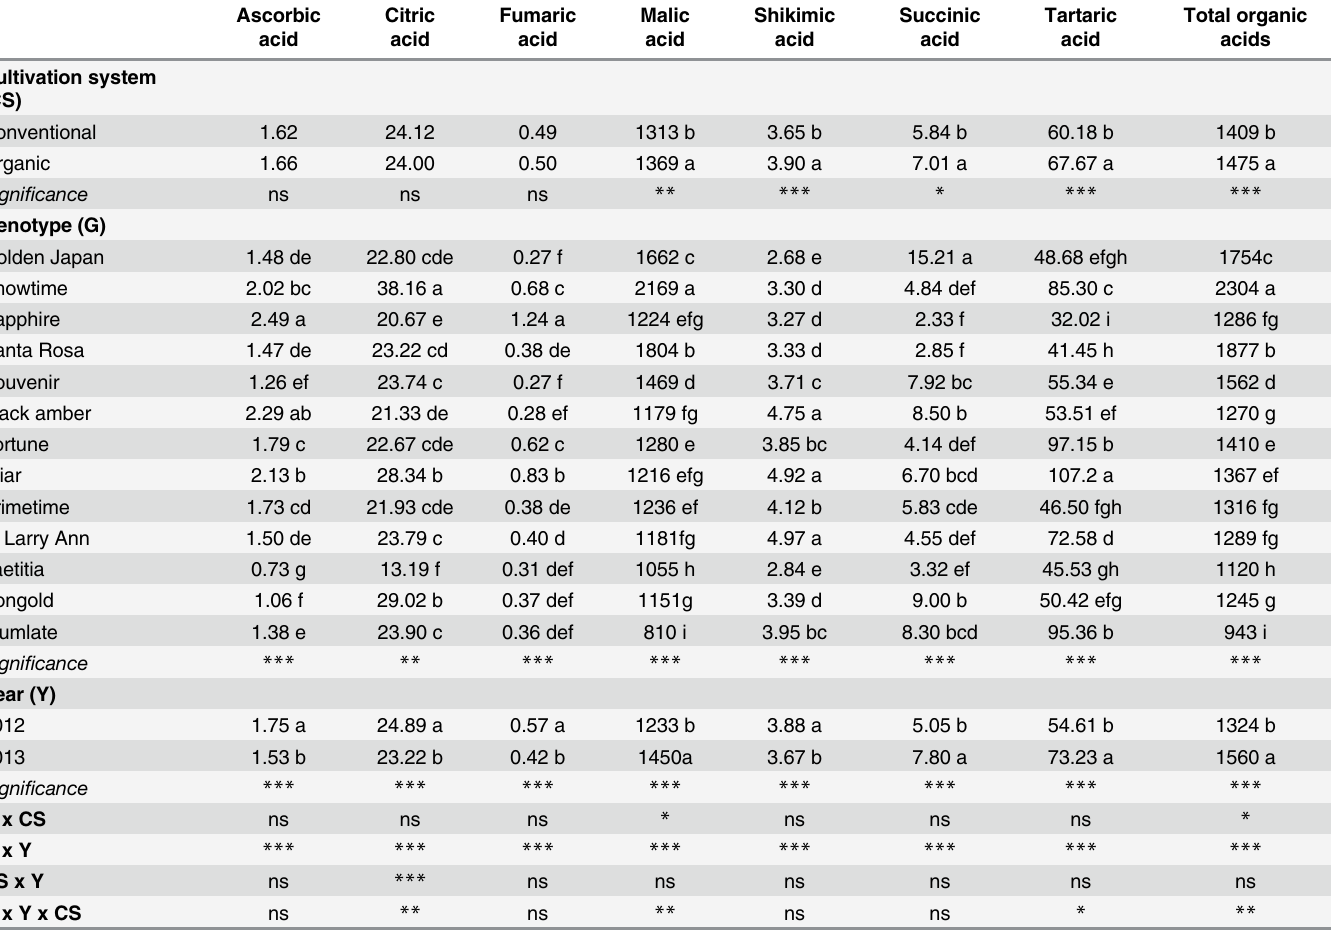
Table 3. Effects of cultivation system, genotype and year of harvest on the malic, citric, ascorbic, succinic, tartaric, fumaric, shikimic and total organic acids content in plums. Ascorbic